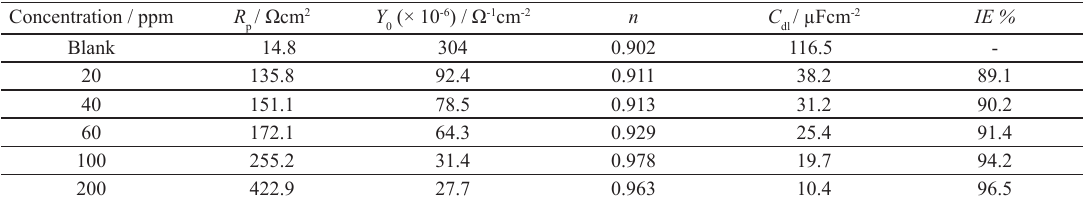
Table 2. Impedance parameter values for the corrosion of mild steel in 1N HCl and 1N H inhibitor. Concentration /